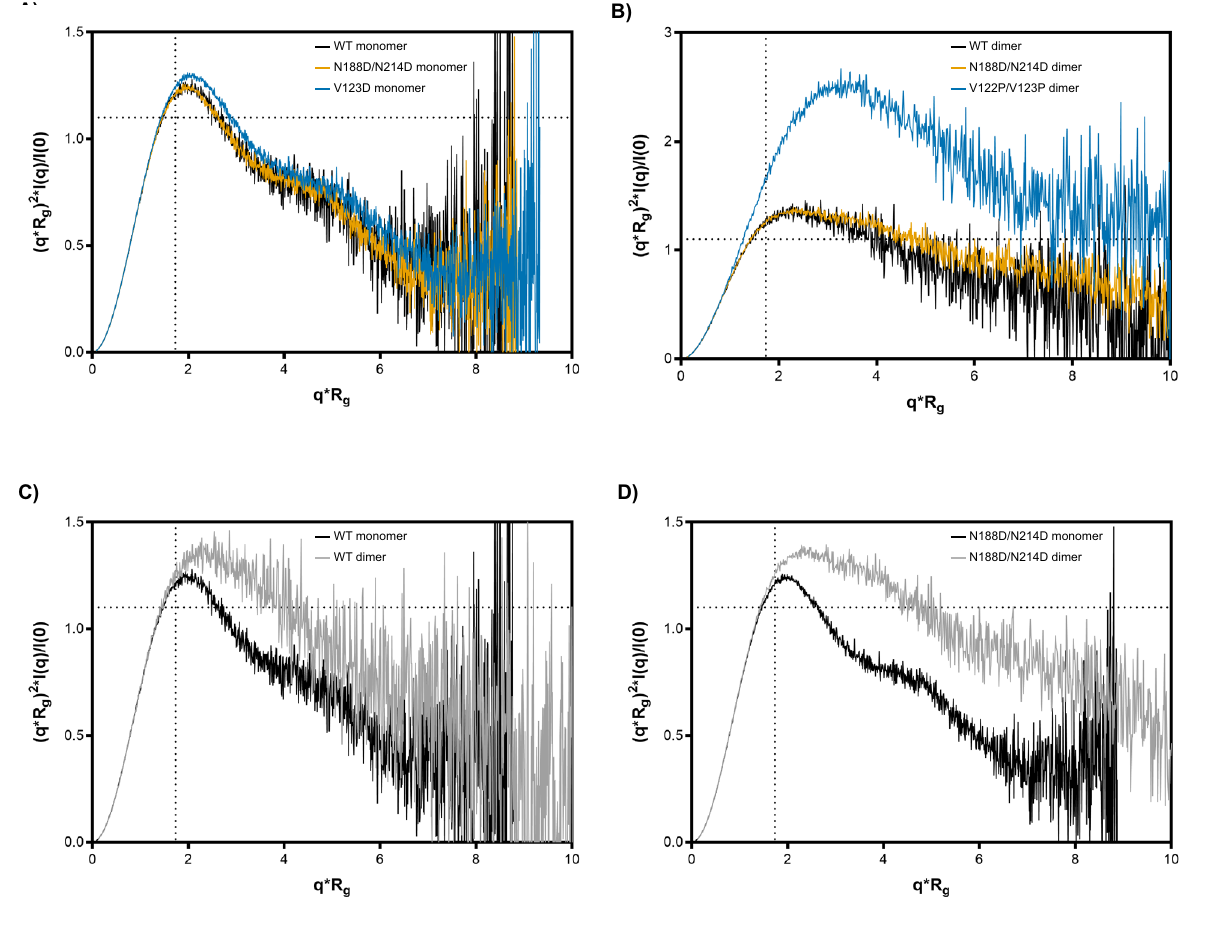
Figure 5. Kratky analysis for flexibility and compactness. Overlays of normalized Krakty plots are shown for monomers ( A ) and dimers ( B ). Comparisons between WT monomer and dimer ( C ) and N188D/N214D monomer and dimer ( D ) are shown. Dotted lines indicate where the maxima are expected to occur for an ideal, compact, globular protein (qR g ~ 1.73 for the peak position; ~ 1.1 for the peak